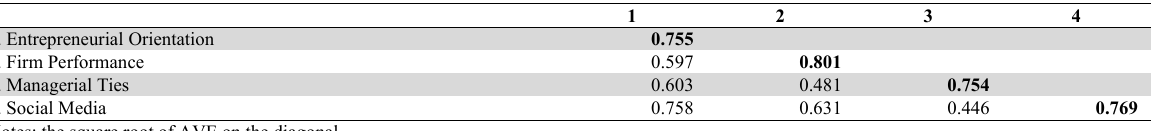
Notes: the square root of AVE on the diagonal.